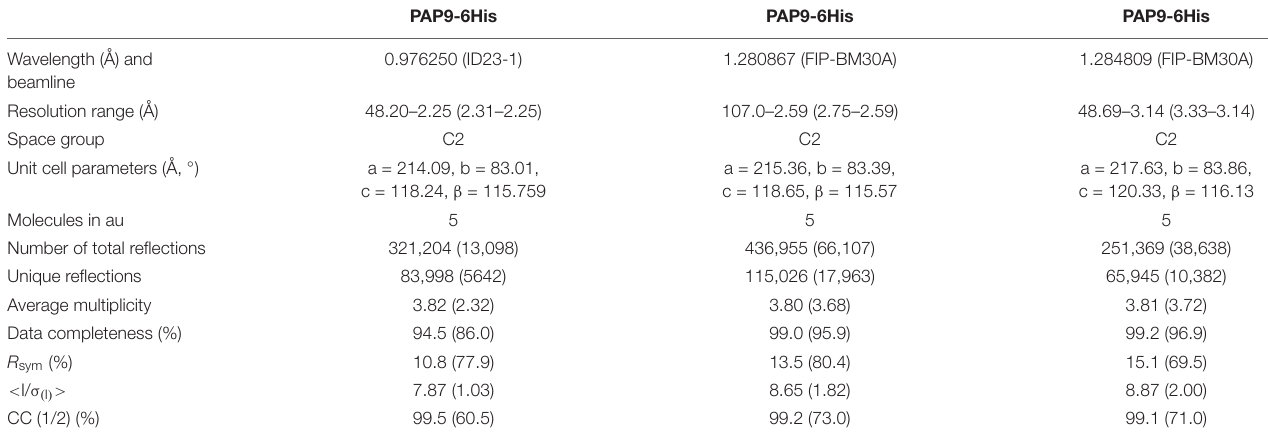
TABLE 1 | Statistics of data